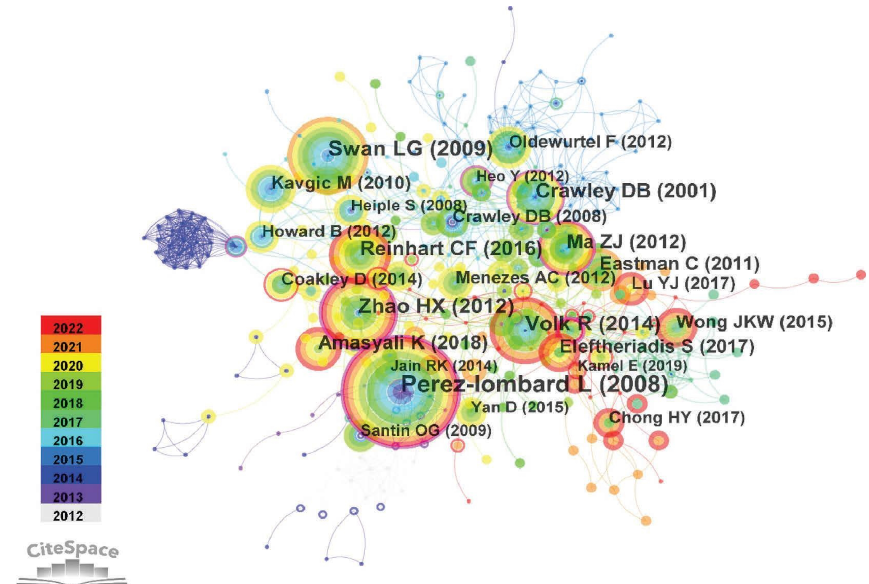
Figure 9: Literature cocitation